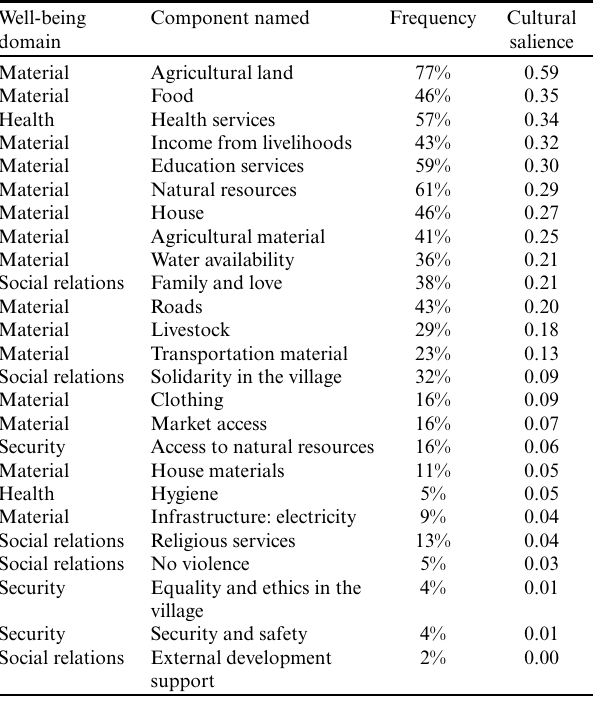
Table 4. Salience score and associated frequency of well-being components named in individual interviews across the three villages, ranked according to cultural salience.